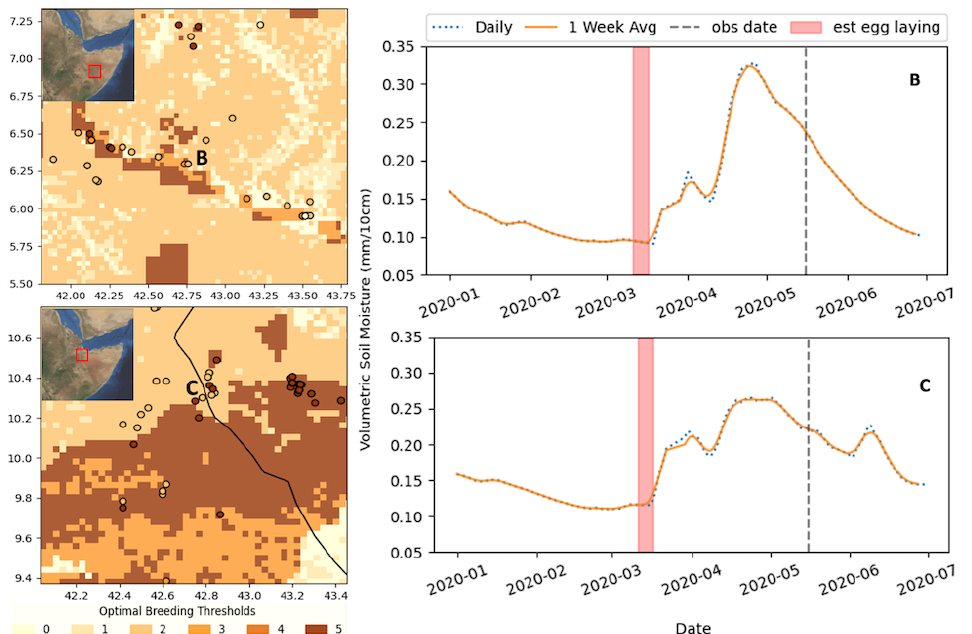
Figure 3. Optimal breeding classification map for 14 March (weekly average SM), which corresponds to 265 DL observations between 14 and 18 May, and the corresponding SM time series for two example cases in March for two regions in Ethiopia: B—Shabelle River and C—just south of Djibouti. The approximate location of the time series is annotated in the map in red. See the text or Figure 2 for threshold